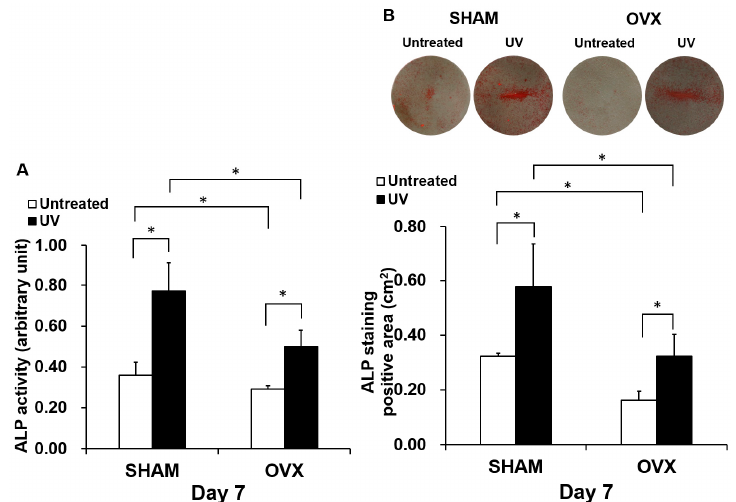
Figure 5. UV light-enhanced alkaline phosphatase (ALP) activity, an early- to middle-stage marker of osteoblasts, in the OVX and sham groups. ( A ) Colorimetrically quantified ALP activity standardized per cell at day 7 is shown. ( B ) ALP activity measured as the ALP-positive (red) area at day 7. Representative images of the stained culture are presented on the top. The ALP-positive area measured from the images is presented at the bottom histogram in square centimeters. Each value represents the mean ± standard deviation of triplicate experiments ( n = 3). * p < 0.05, significant difference between untreated and UV light-treated surfaces.